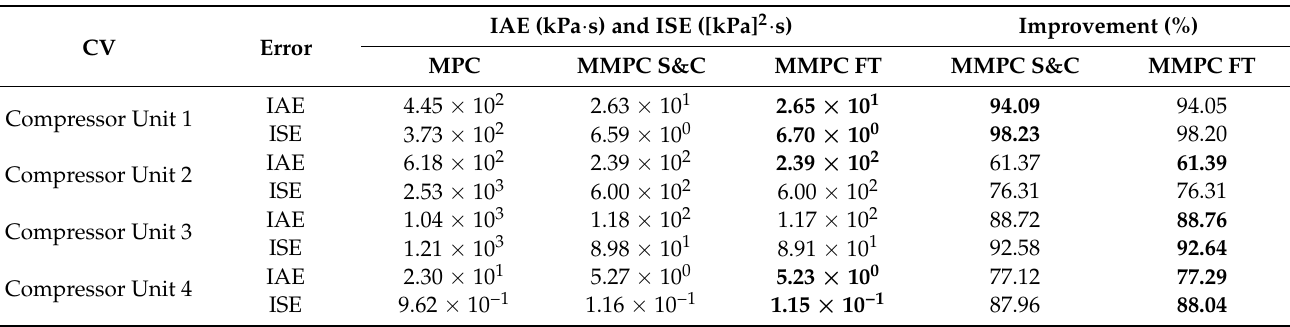
Table 8. Comparison of IAE and ISE on the compressor unit with changes on compressor unit 2 (MIMO Model 1).